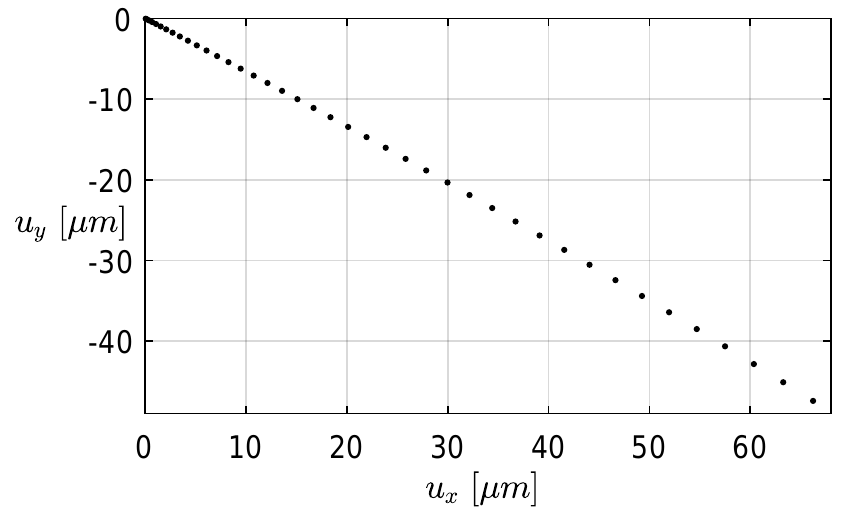
Figure 10. Tip path followed by the four-bar microgripper along the x - and y -axes (see the Reference system represented in Figure